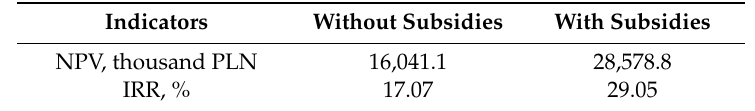
Table 1. Findings of NPV and IRR of investment in energy recovery system with and without subsidies. Indicators Without Subsidies With